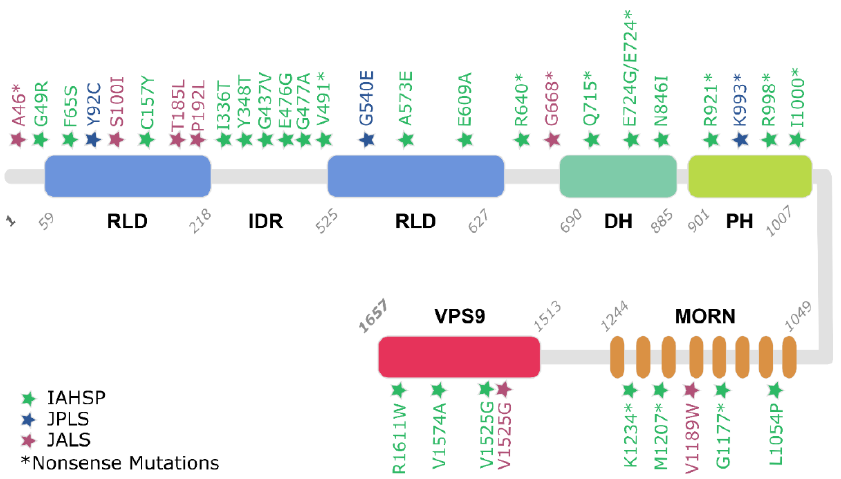
Figure 2. Reported Alsin mutations, inducing IAHSP, JPLS, and JALS. Mutation positions are indi- cated with colored stars and type of mutation is reported following a commonly used nomenclature (e.g., G49R).